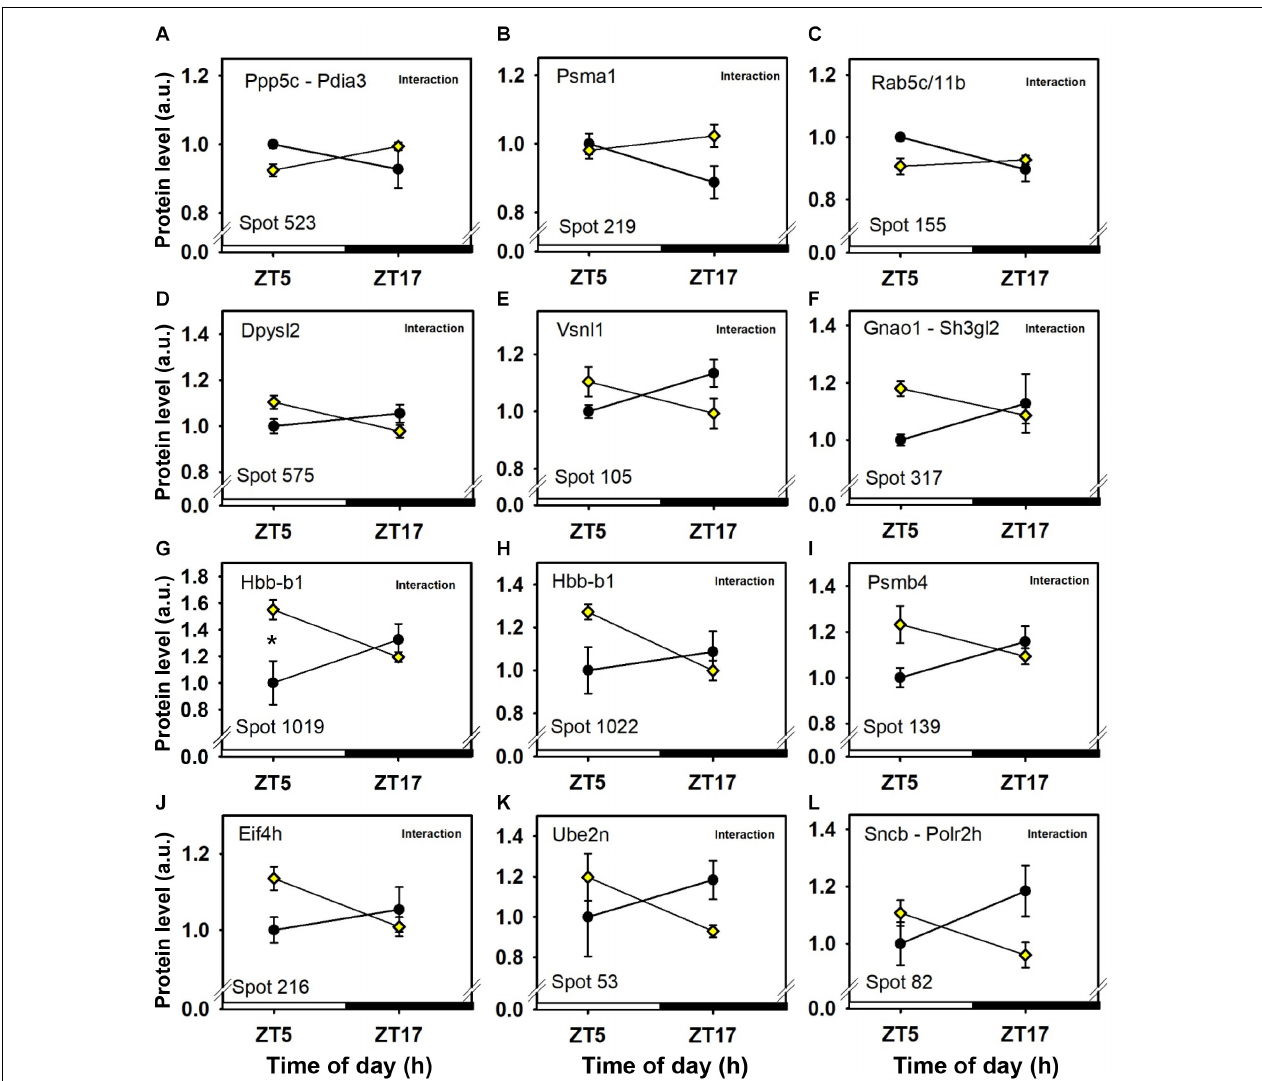
FIGURE 7 | Day–night expression of cerebellar proteins mostly affected by interactions between feeding conditions and time-of day. From analyses in control mice fed ad libitum (closed circles) and mice exposed to daytime restricted feeding (yellow diamonds), “Interaction” indicates significant ( P < 0.05) time-of-day × feeding interaction, respectively, as detected by two-way ANOVA (see section “Materials and Methods” for details). * P < 0.05 after post hoc Tukey comparison. Different part labels have been attributed to each differentially-expressed proteins; see details in the main